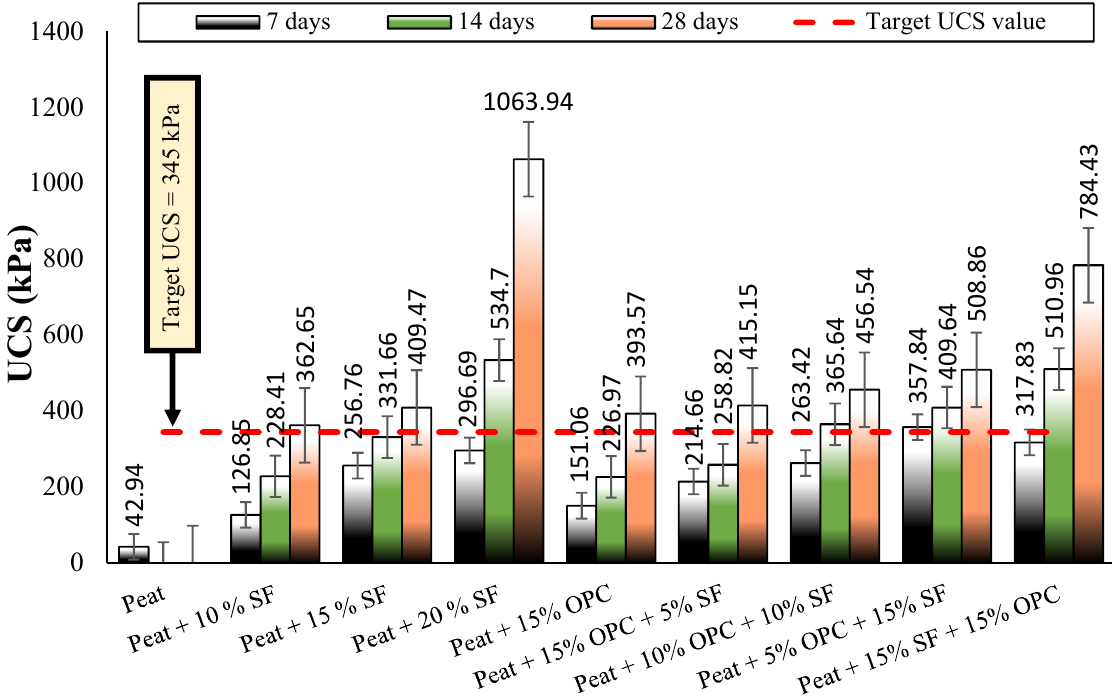
Figure 6. Comparing the compressive strength of untreated peat and stabilized peat after 7, 14, and 28 days of curing.